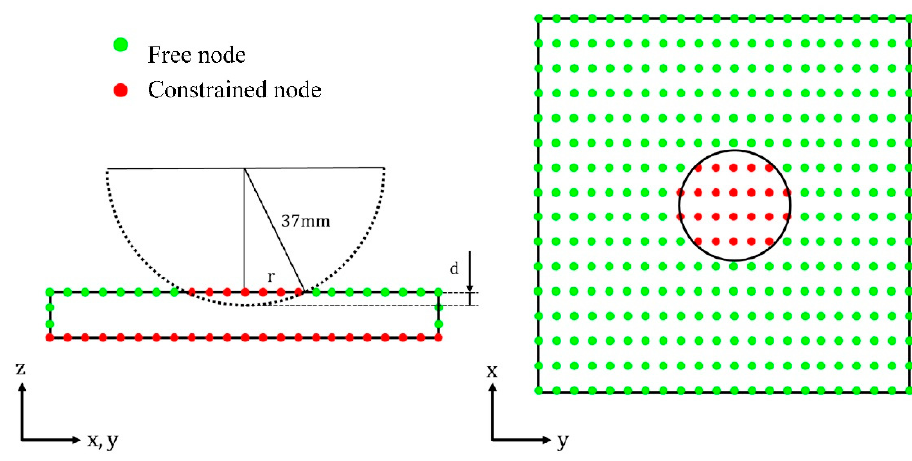
Figure 5. Boundary condition of FEA